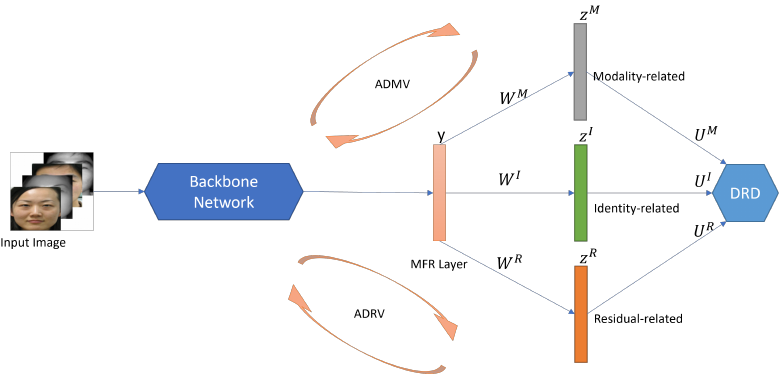
Figure 16. The flowchart of DADRD model proposed in